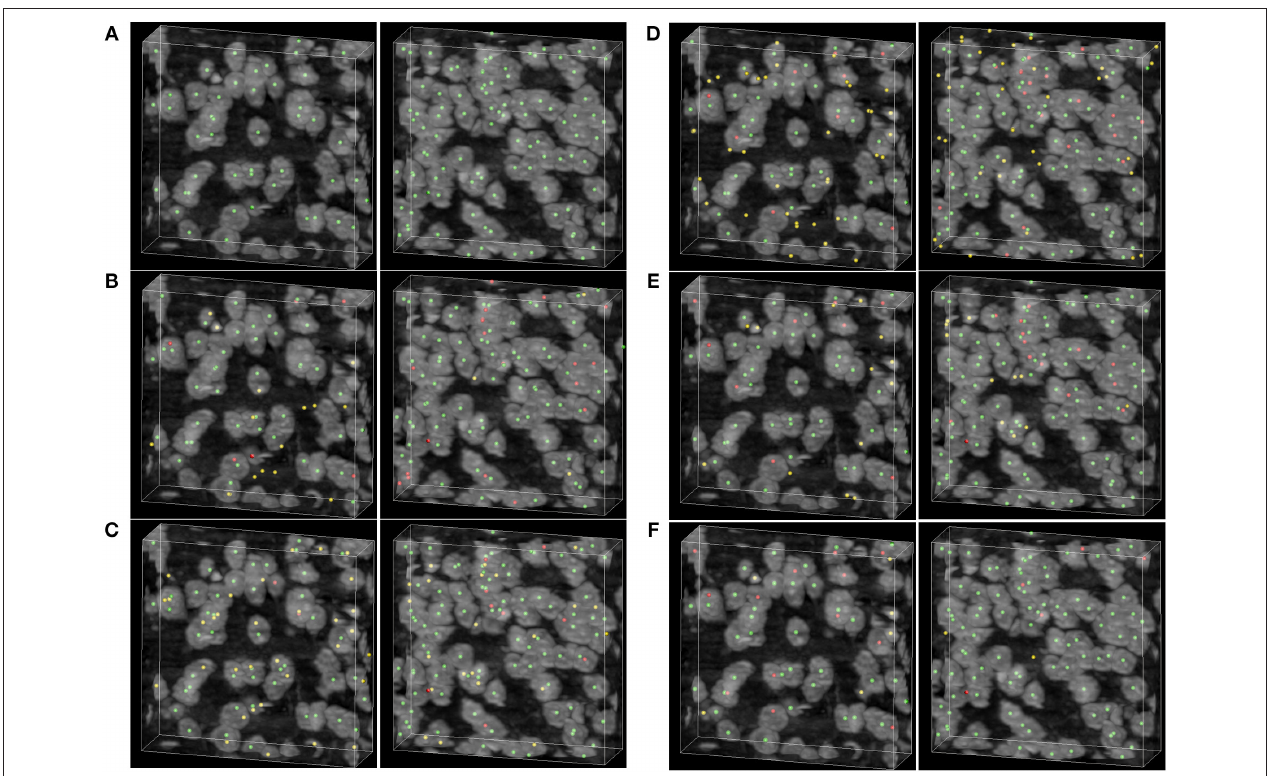
FIGURE 6 | Localization results. (A) Ground truth; the neuronal soma location is demonstrated by neuronal soma centers labeled using green balls. (B) Distance transform based rayburst sampling algorithm, (C) CPC random walker (D,E) 3D UNet and VNet, respectively. (F) Proposed method. The falsely detected somata are labeled using yellow balls and the missing neuronal somata are labeled using red balls. The shape of the volumetric data is 200 × 200 × 60 voxels, and the voxel size is 0.35 × 0.35 × 0.35 µ m.